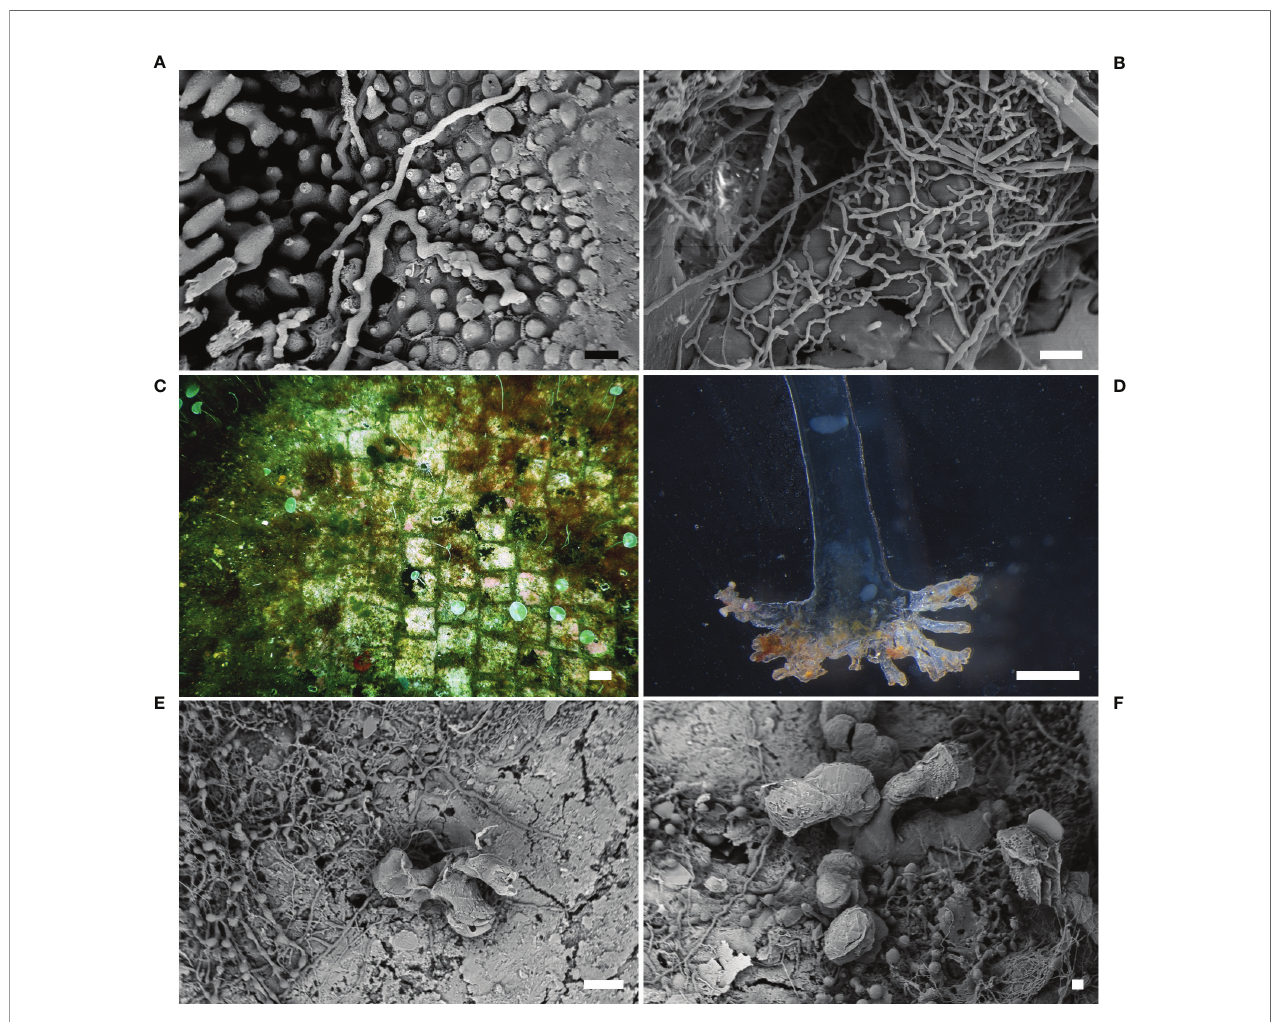
FIGURE 3 | Green algae. (A) The ichnospecies Ichnoreticulina elegans (SEM image); (B) the typical zig-zag shaped networks of I. elegans (SEM image); (C) specimens of Acetabularia acetabulum on the calcareous marble tesserae of the Villa dei Pisoni Mosaic fl oor in Baiae, Naples (underwater photo); (D) endolithic rhizoid of the green alga A. acetabulum (stereomicroscope image); (E) the branched rhizoidal apparatus of the green alga A. acetabulum (SEM image); (F) detail of the branches of the endolithic rhizoid of A. acetabulum (SEM image) Scale bars: (A) = 10 µm; (B) = 20 µm; (C) = 1 cm; (D) = 0.5 mm; (E) = 100 µm; (F) = 20